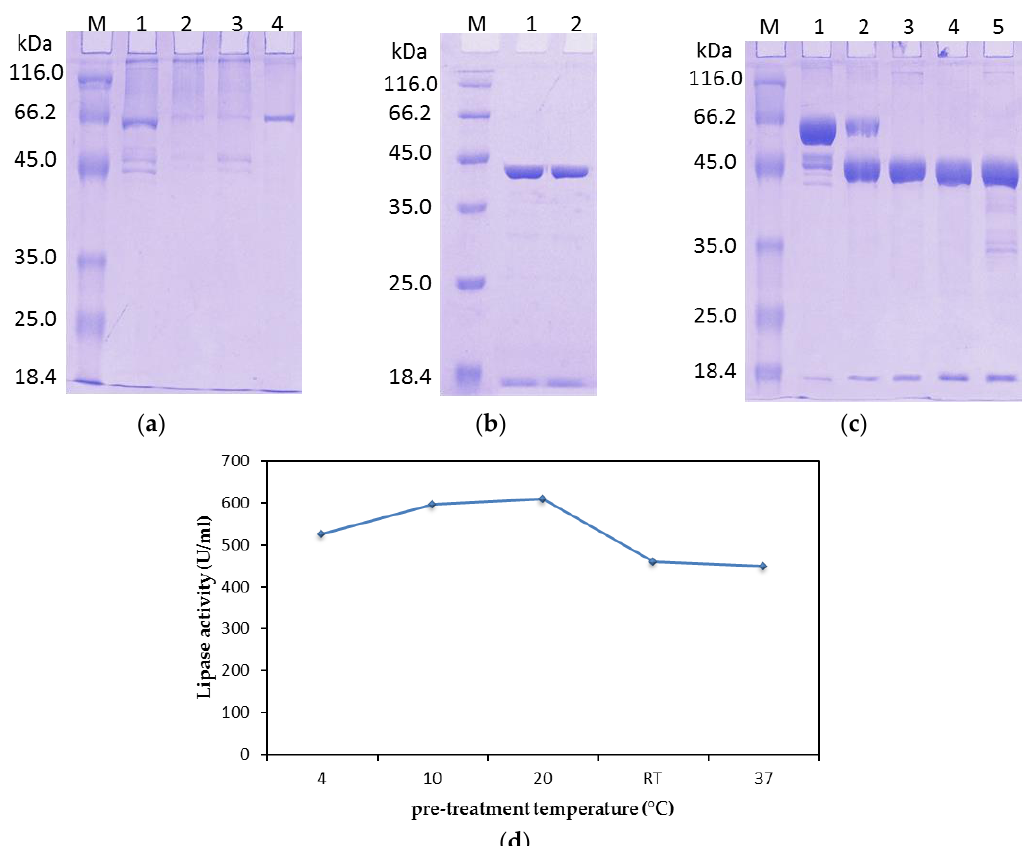
Figure 2. Effect of Recombinant Enterokinase and temperature on the fusion rHZ lipase tag-cleavage. ( a ) Optimization of minimum rEK concentrations to cleave the tags of the target protein. The mixtures were incubated at 20 °C for 16 h. Lane M: Protein marker, lane 1: 0.1 U rEK, lane 2: 0.2 U rEK, lane 3: 0.5 U rEk, lane 4: 0 U rEK (control). Note: After 16 h of incubation with different rEK concentrations,